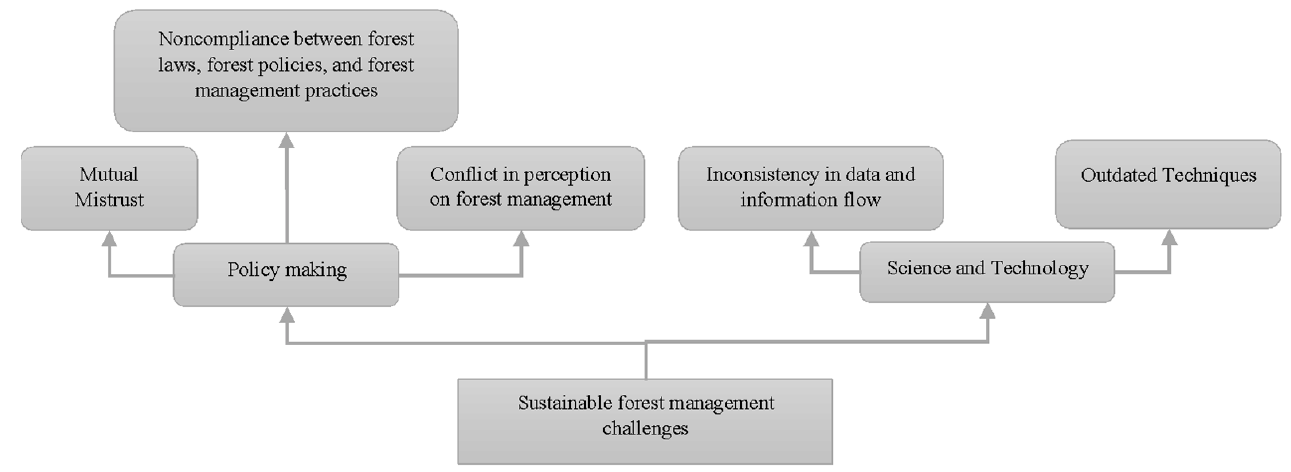
Figure 2. Challenges facing the implementation of SFM in the Hyrcanian forests.